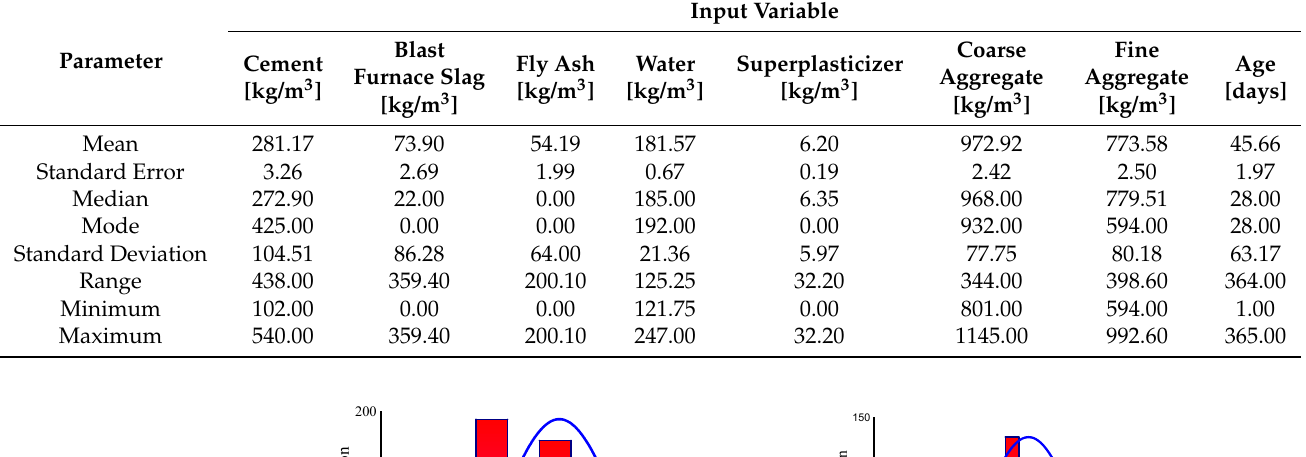
Table 1. Descriptive analysis of input parameters.